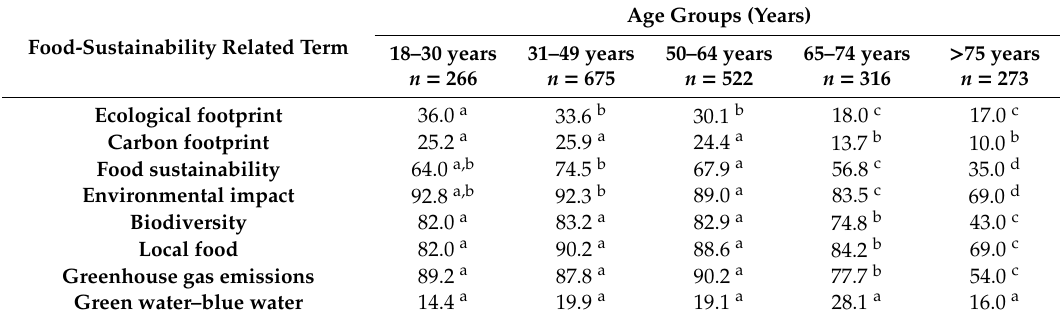
Table 2. Percentage of Spanish adult population that stated knowing the meaning of di ff erent terms related with food sustainability, by age